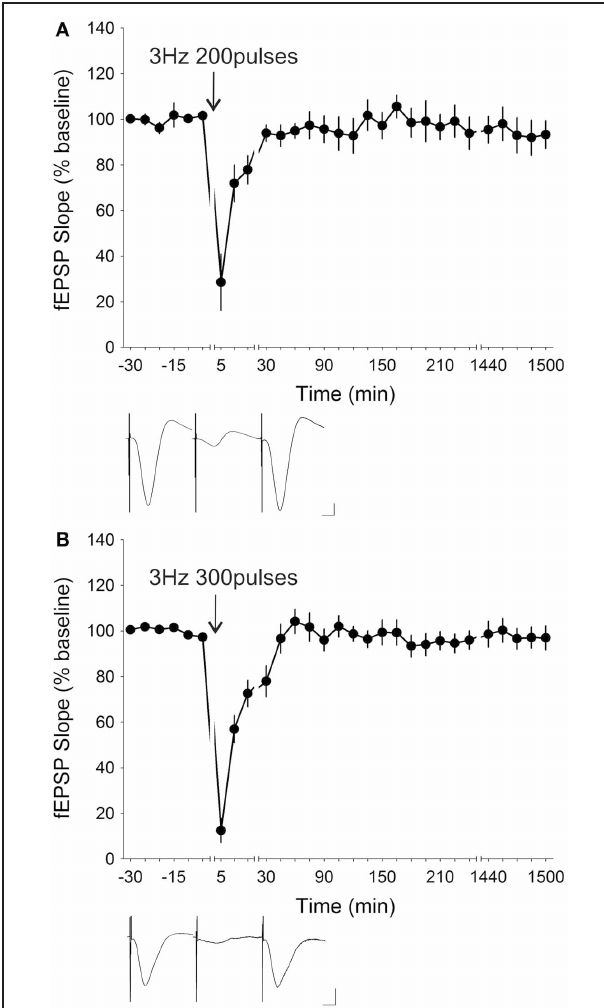
FIGURE 4 | Low-frequency stimulation at 3Hz given for 200 or 300 times induced robust short-term depression. (A) Low-frequency stimulation (LFS) given at 3Hz for 200 stimuli (ANOVA, p < 0 . 05; n = 6) and (B) 300 stimuli (ANOVA, p < 0 . 05; n = 9) both induced robust and significant short-term depression (STD). Increasing the number of stimuli by 100 from 200 to 300 at 3Hz resulted in an enhancement in the initial synaptic depression from 28 . 52 ± 12 . 28% to 12 . 46 ± 5 . 35% whilst post-hoc analysis revealed an increase in the duration of significant synaptic depression from 15min to 30min post-stimulation. Insets: analog traces illustrating the Schaffer collateral–CA1 field potentials at pre-stimulation, 5min and 24h (1440min). Vertical scale bar corresponds to 2mV and horizontal scale bar corresponds to 5ms.